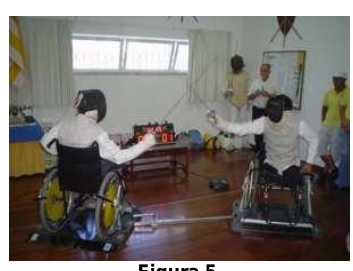
Figura 5. http://www.barlavento.online.pt/upload/multimedia/1